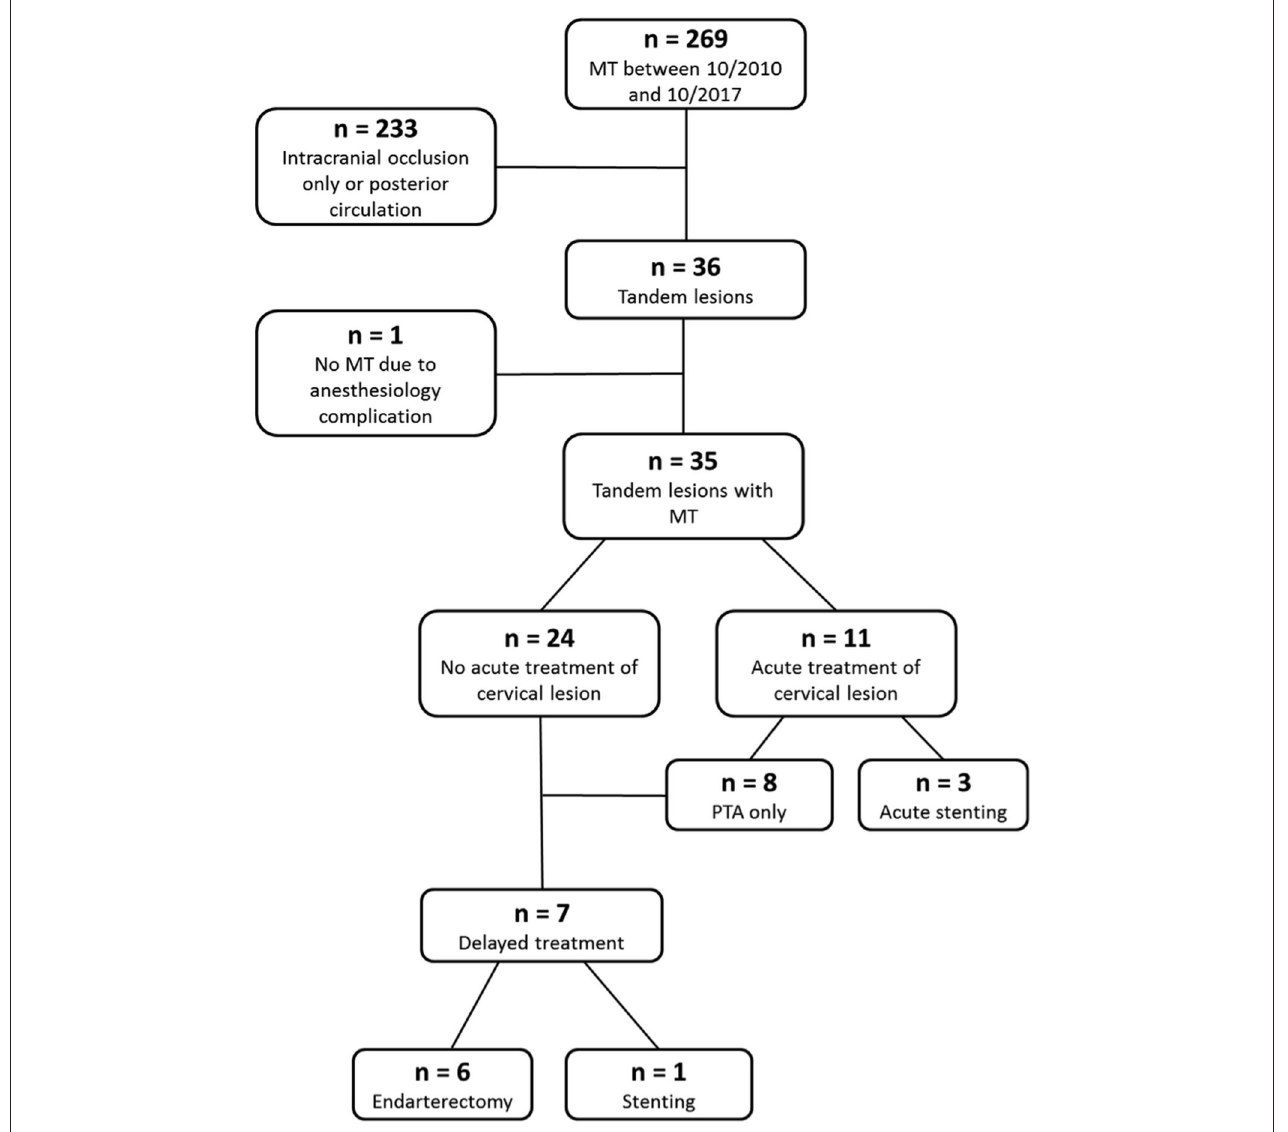
FIGURE 1 | Flowchart of the study